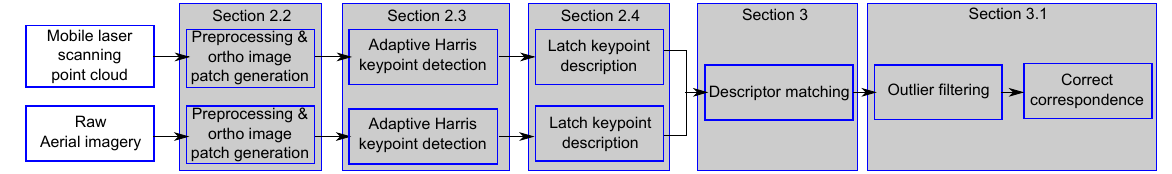
Figure 1. Flow diagram of the developed method for MLSPC to Aerial image